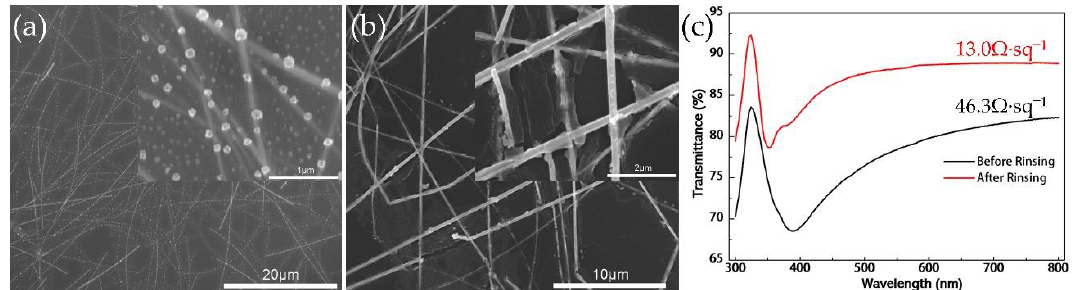
Figure 2. SEM images of AgNW – Al 2 O 3 composite film (electrodeposition time and temperature: 40 s @ 70 °C) ( a ) before rinsing and ( b ) after rinsing. ( c ) UV-visible transmission spectra before and after rinsing.